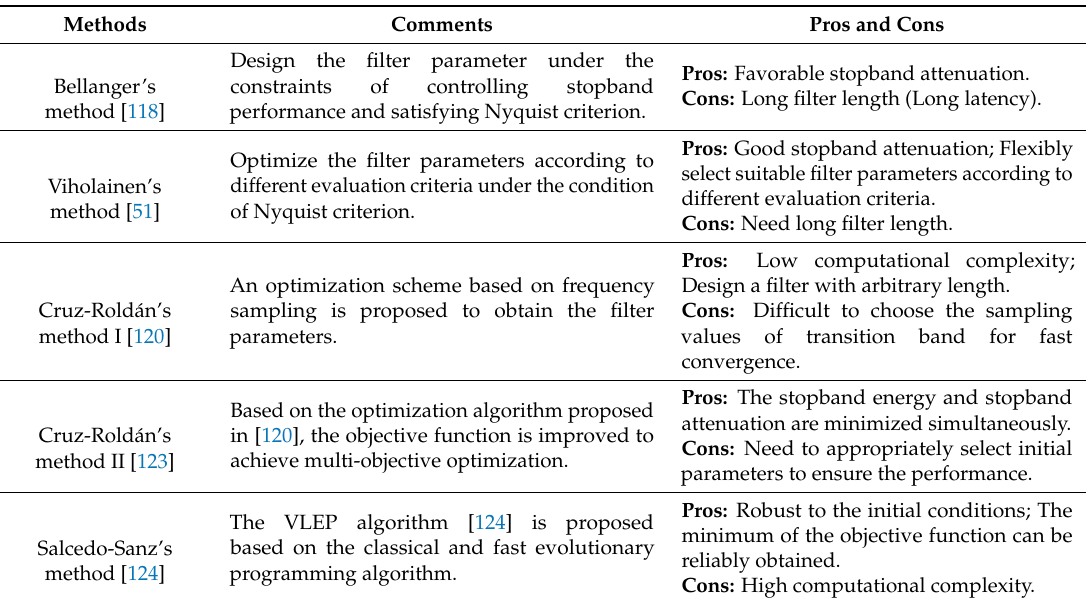
Table 2. Summary of frequency sampling